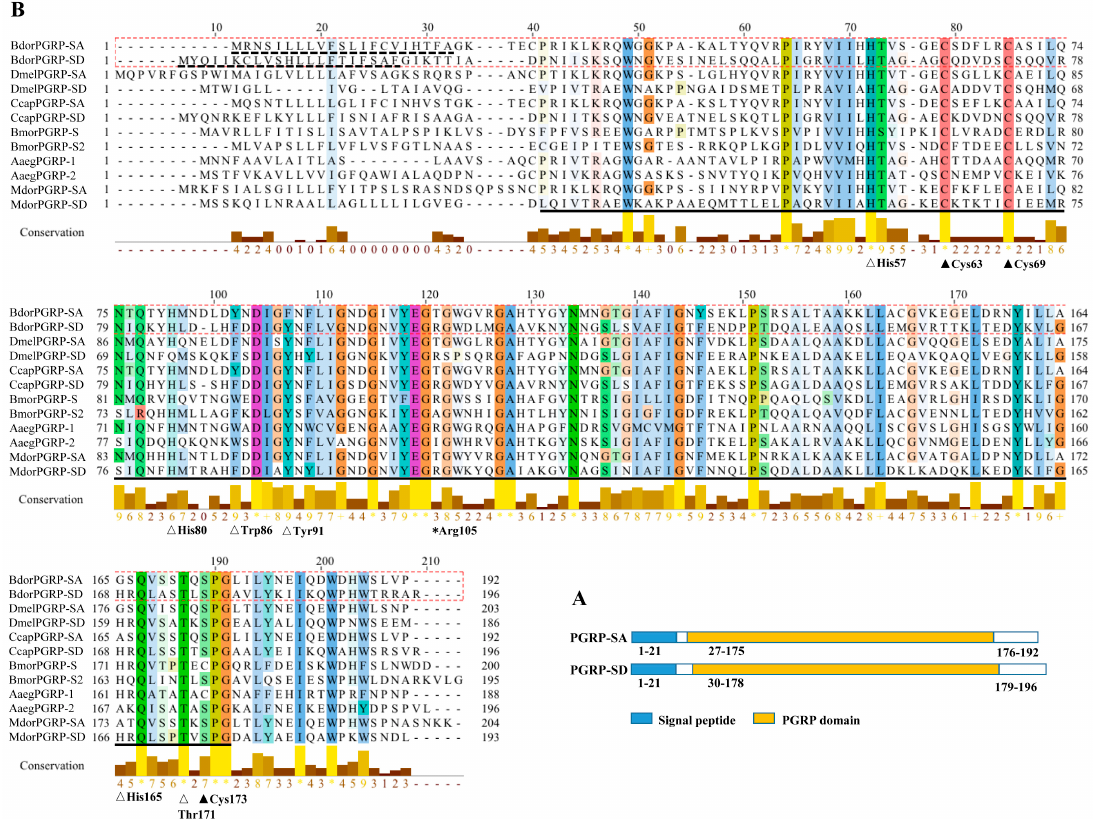
Figure 1. Structure of the signal peptide and conserved domain of two BdPGRPs ( A ), and multiple sequence alignment of PGRPs from insects ( B ). The blue bar and yellow bars in panel A indicate the signal peptide and conserved PGRP domain, respectively. The dashed line indicates the signal peptide amino acids, and the black line indicates the conserved PGRP domain region. The black triangles in panel B indicate the conserved cysteine residues, the clear triangles indicate the amino acid residues required for PGRP/amidase activity, and the asterisk indicates the amino acid responsible for the recognition of DAP-PGN. The heights of the yellow or brown bars below the aligned sequences represent the degree of similarity of the amino acids. Bdor, Dmel, Ccap, Bmor, Aaeg, and Mdom indicate the insects of Bactrocera dorsalis , Drosophila melanogaster , Ceratitis capitata , Bombyx mori , Aedes aegypti , and Musca domestica , respectively.